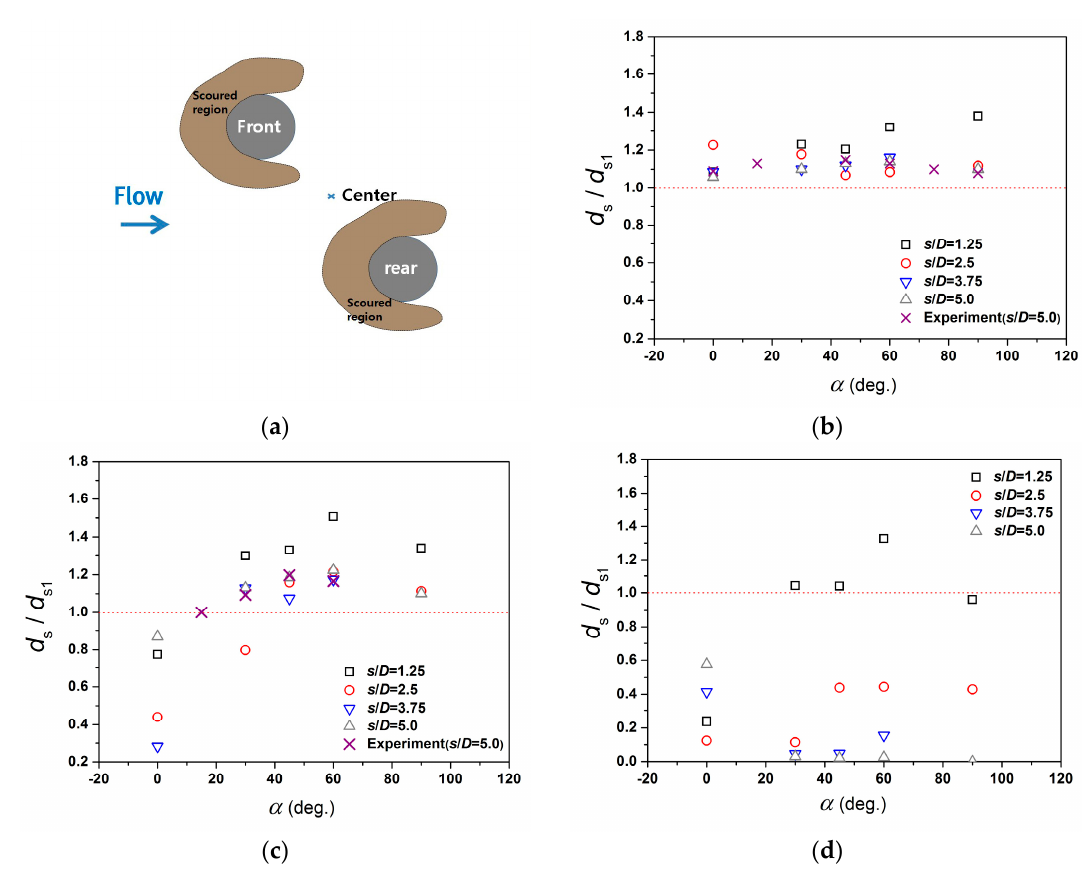
Figure 10. Local scour depth: ( a ) Schematic view of maximum scour areas around two cylinders; ( b ) Maximum scour depth at the front cylinder; ( c ) Maximum scour depth at the rear cylinder; ( d ) Local scour depth at the center location between two cylinders.